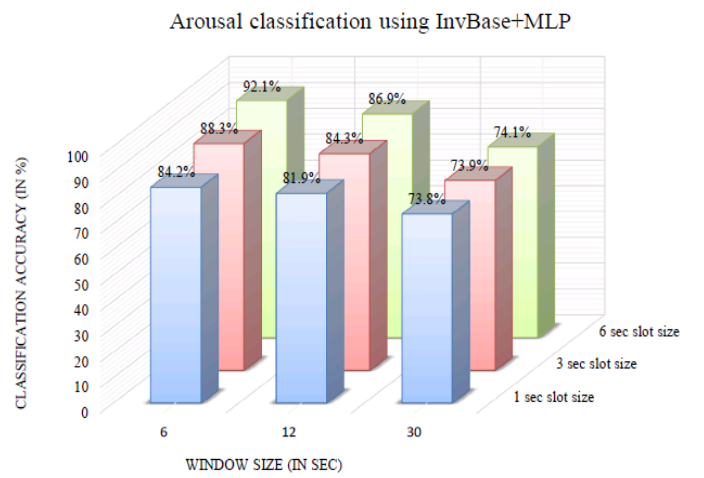
Figure 6. Arousal classification accuracy of the InvBase+MLP method for various window sizes.